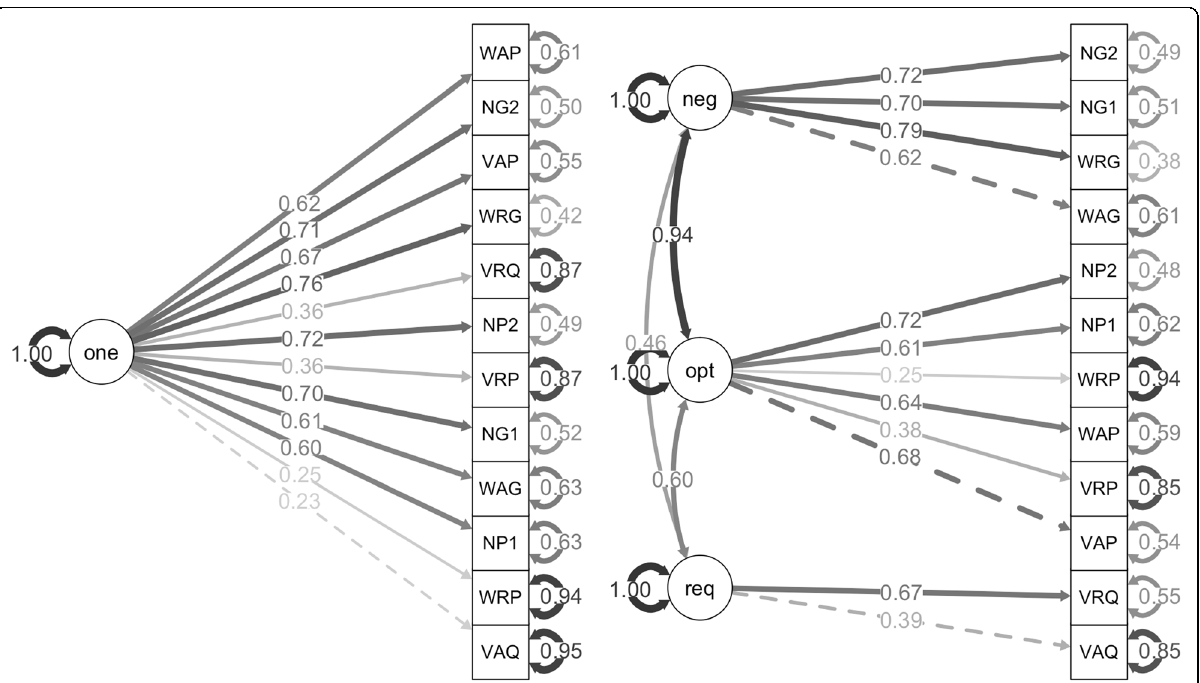
Fig. 5 One-factor model (left) and level of spatial-thinking model (right) for ratings of spatial-thinking involvement. One-factor model (one); negligible (neg), optional (opt), and required spatial thinking (req). The math problem were labeled first by type: visual (V), word (W), and notation (N); second by context: real-world (R), abstract (A), and notation (N); and third by level of spatial thinking: required (Q), optional (P), and negligible (G). Since notation types were also notation contexts, we balanced the number of problems by including two of each of these problems (indicated with a 1 and